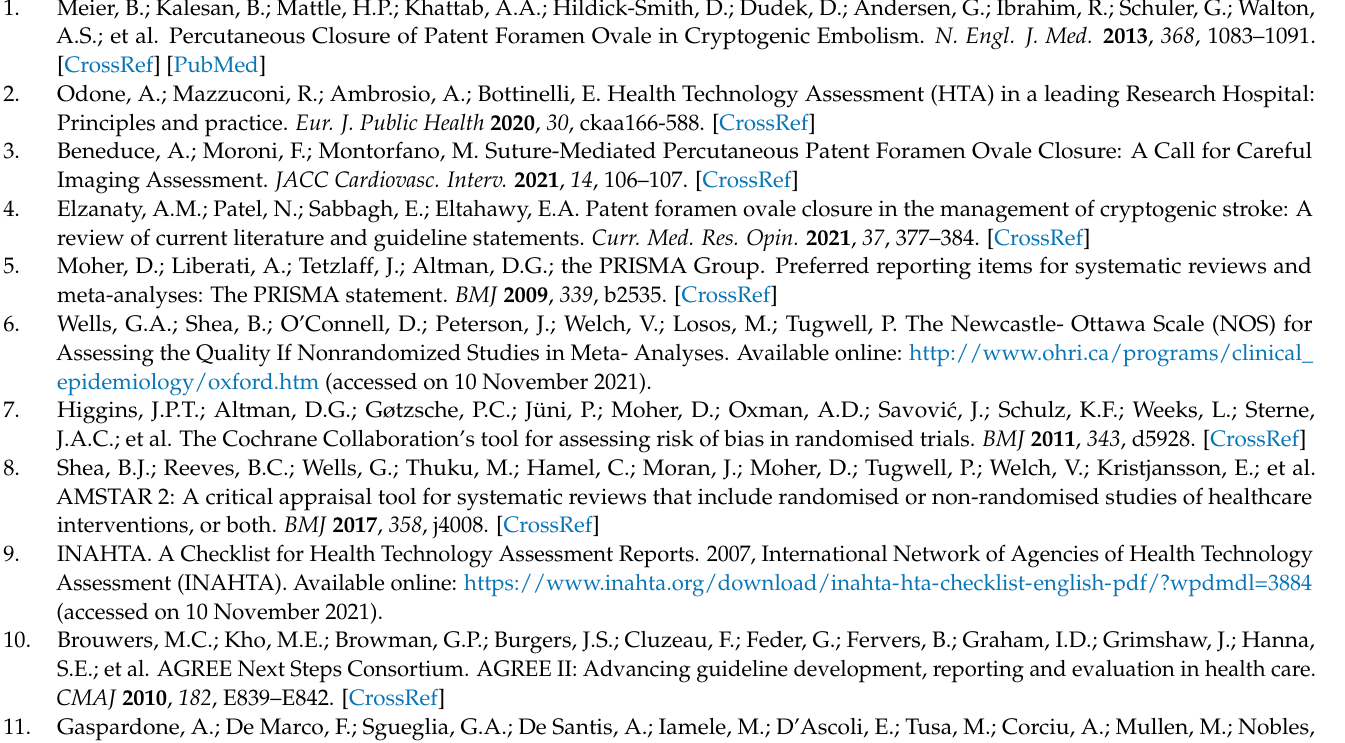
interviewed for Qualitative Domains. Figure S1—The NobleStitch EL system kit. Figure S2—The No- bleStitch EL procedure. Figure S3—The NobleStitch EL procedure step by step. Figure S4—Baseline clinical characteristics. Figure S5—Patients treated with NobleStitch EL at IRCCS San Raffaele Hospi- tal. Figure S6—Screening PRISMA of Primary literature. Figure S7—Screening PRISMA of Clinical Trials registries. Figure S8—PRISMA Flow Chart for the Second Systematic Review on Amplatzer PFO